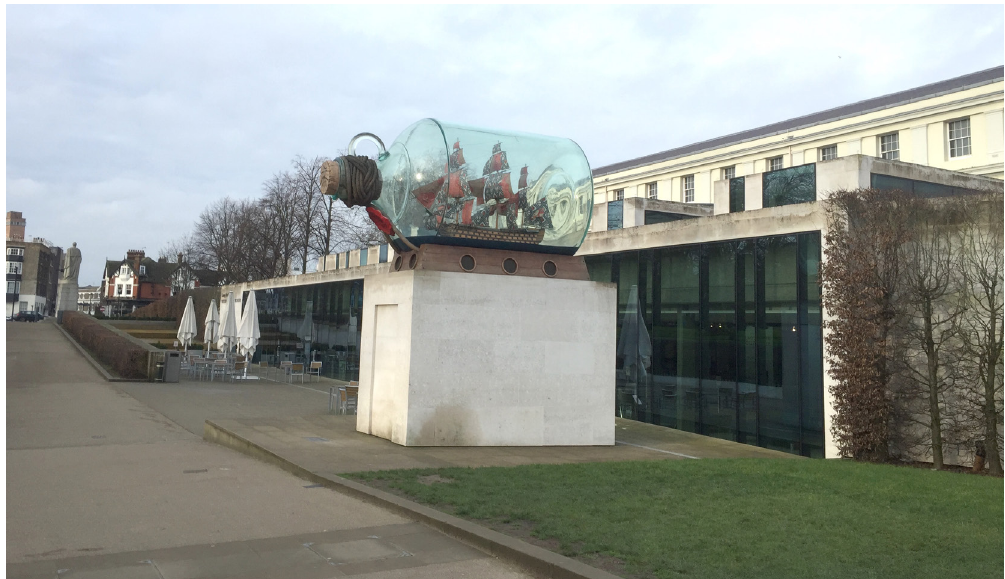
Figure 4: Yinka Shonibare’s Nelson’s Ship in a Bottle installed at the National Maritime Museum, Greenwich. Photograph